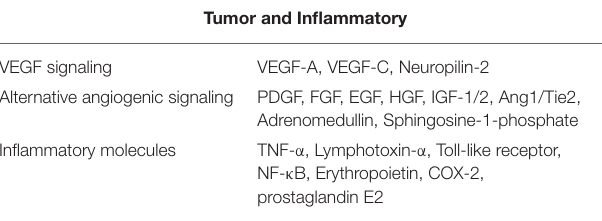
TABLE 2 | The signals and molecules that causes induction of lymphangiogenesis. Tumor and Inflammatory VEGF